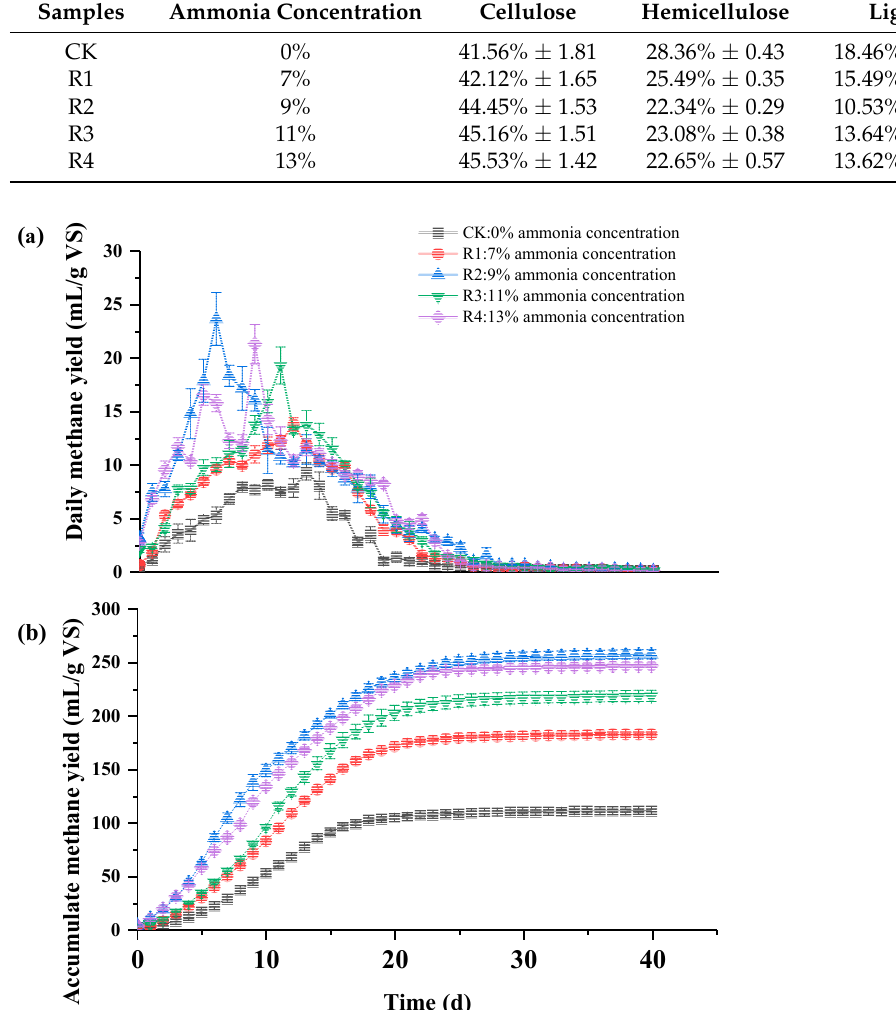
Table 2. Component analysis of corn straw before and after ammonia–mechanical pretreatment. Samples